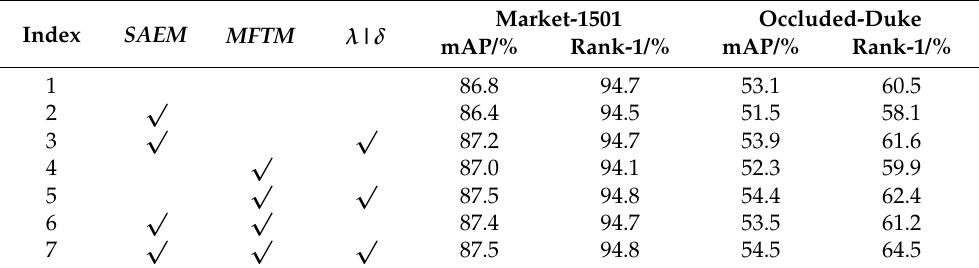
Table 5. Results of ablation study of aet-net on Market-1501 and Occluded-duke datasets. λ | δ denotes the use of the attention-weight